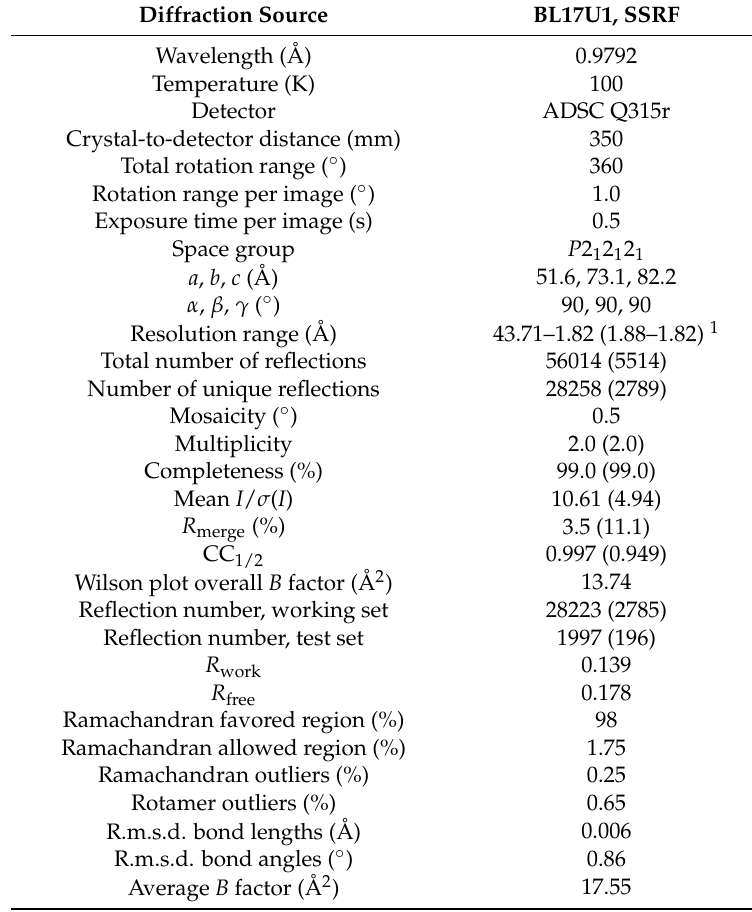
Table 2. Data-collection and crystallographic statistics of cMCR-1- D -xylose